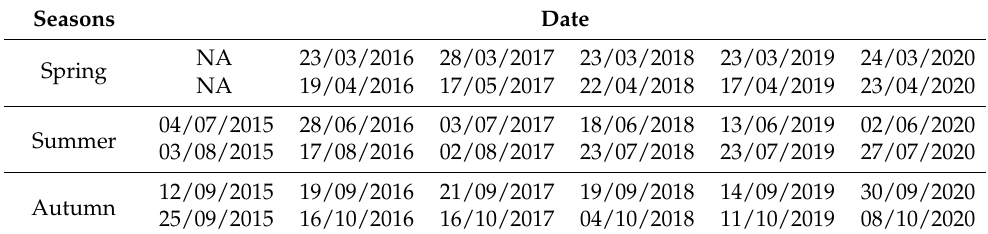
Table 1. Sentinel-2 images used for each year and sorted by season. Seasons Spring